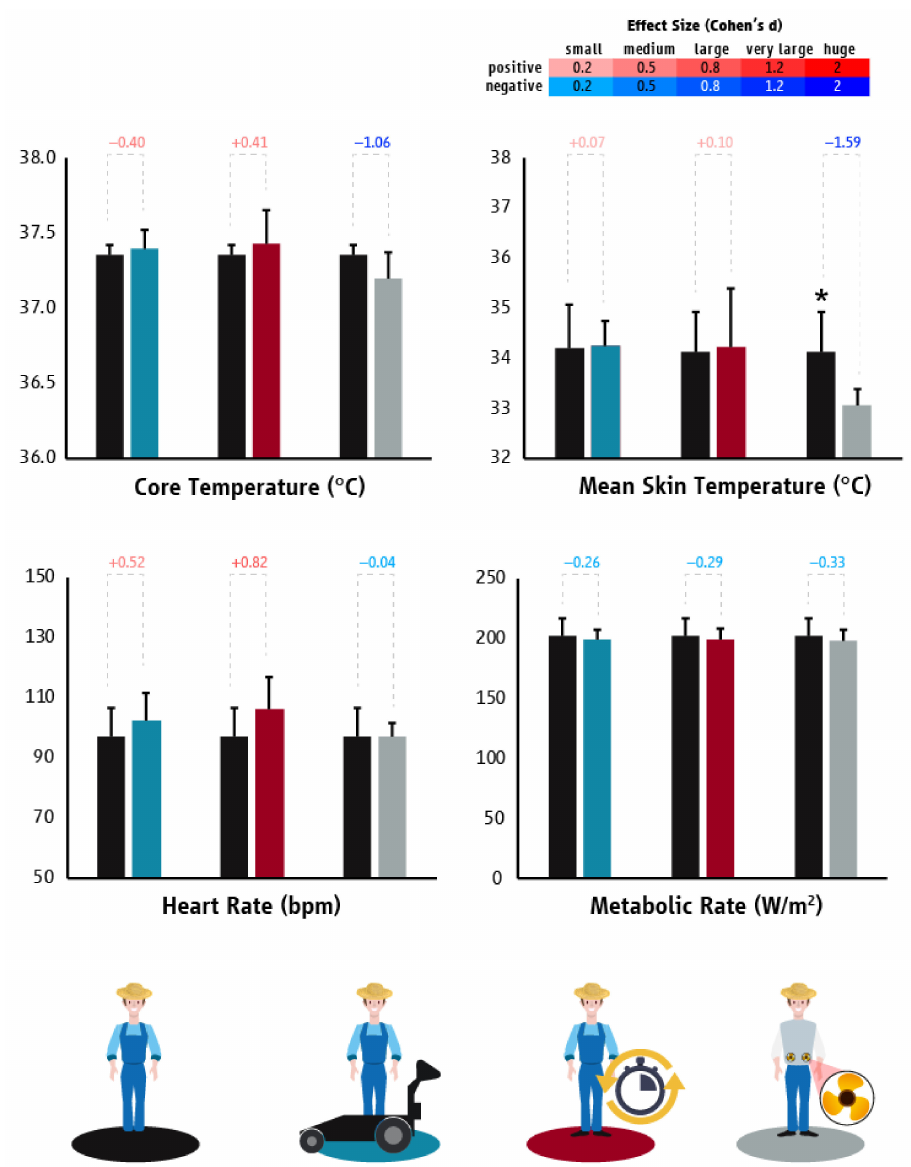
Figure 5. Differences (mean ± SD) in core temperature, mean skin temperature, heart rate, and metabolic rate/work intensity between “business as usual” and the tested heat mitigation strategies in the agriculture sector of Cyprus. Black, light blue, red, and grey colors represent “business as usual”, mechanical fruit cart, planned breaks, and ventilated garments scenarios, respectively. Asterisk indicates statistically significant difference between “business as usual” and the tested heat mitigation strategy. Cohen’s d effect sizes show the magnitude (small: 0.2; medium: 0.5; large: 0.8; very large: 1.2; huge: 2.0) and direction (positive: shades of red; negative: shades of blue) of the differences between “business as usual” and the tested heat mitigation